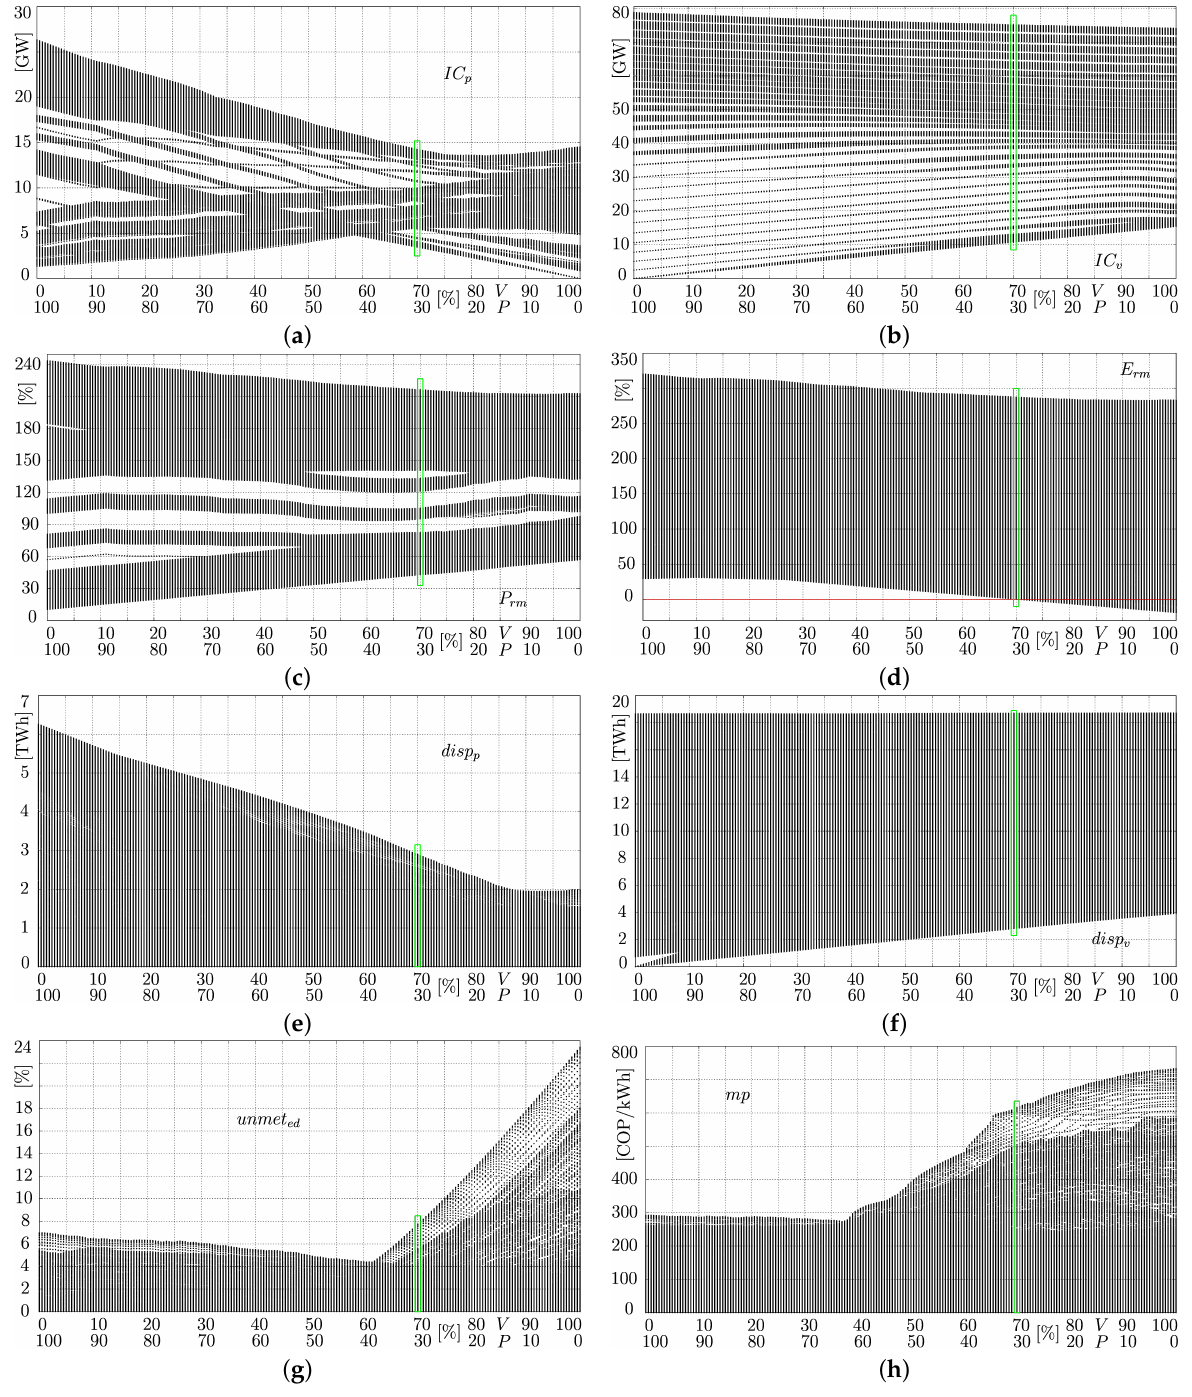
Figure 11. V / P scenarios considering the seasonality and the ENSO phenomenon. The percentage of the variable technology was varied from 0% to 100% in 1% steps as the corresponding percentage of the permanent technology decreased from 100% to 0%. The green rectangles marked represent the solution for the Colombian case (V ≈ 70%, P ≈